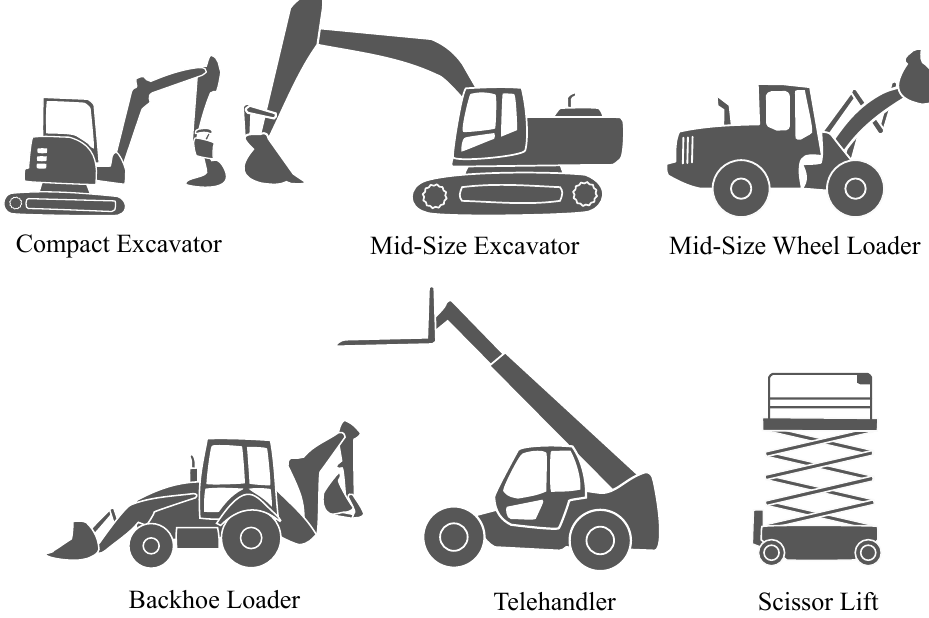
Figure 5. Different types of HDMMs that are evaluated in this